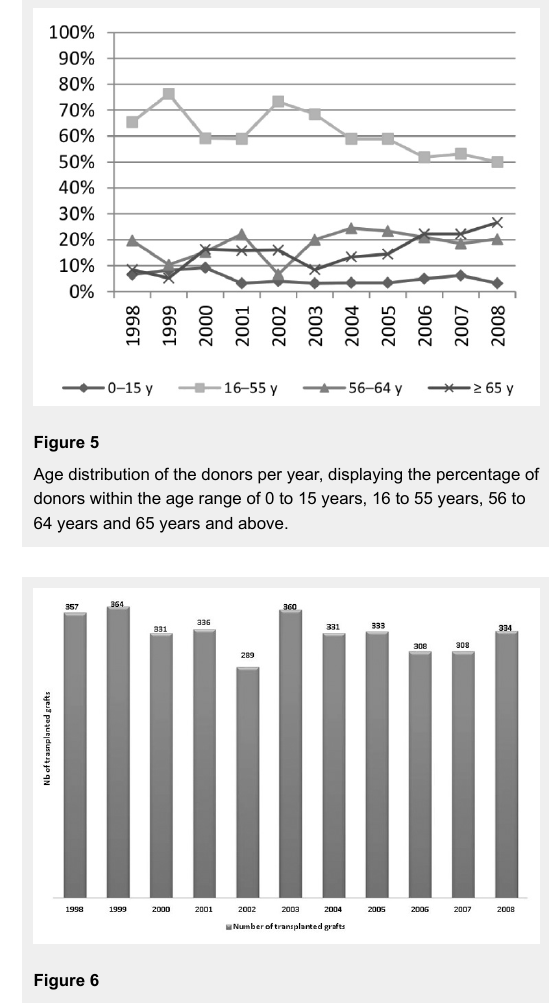
Number of transplanted solid organs in Switzerland. Results displayed for organs procured from deceased donors. Living is not included in this figure.